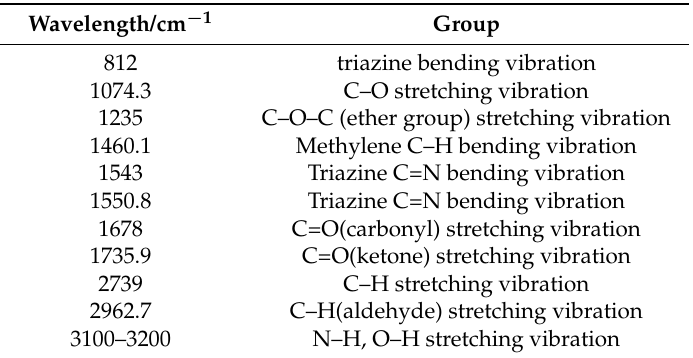
Figure 7. FT-IR spectra of hardened MG and MGG’ resins.